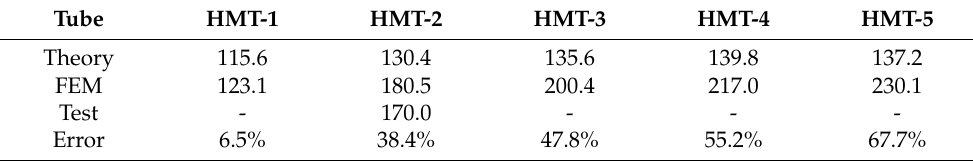
Table 10. Theoretical predicted MCFs for HMTS based on tangent